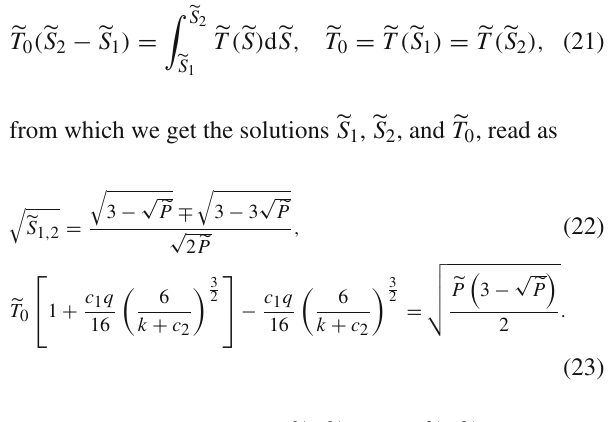
the superheated small black hole and the supercooled large black hole. And the blue curve indicates the black hole is in an unstable phase. The black dashed line implied by equal area law is the phase transition